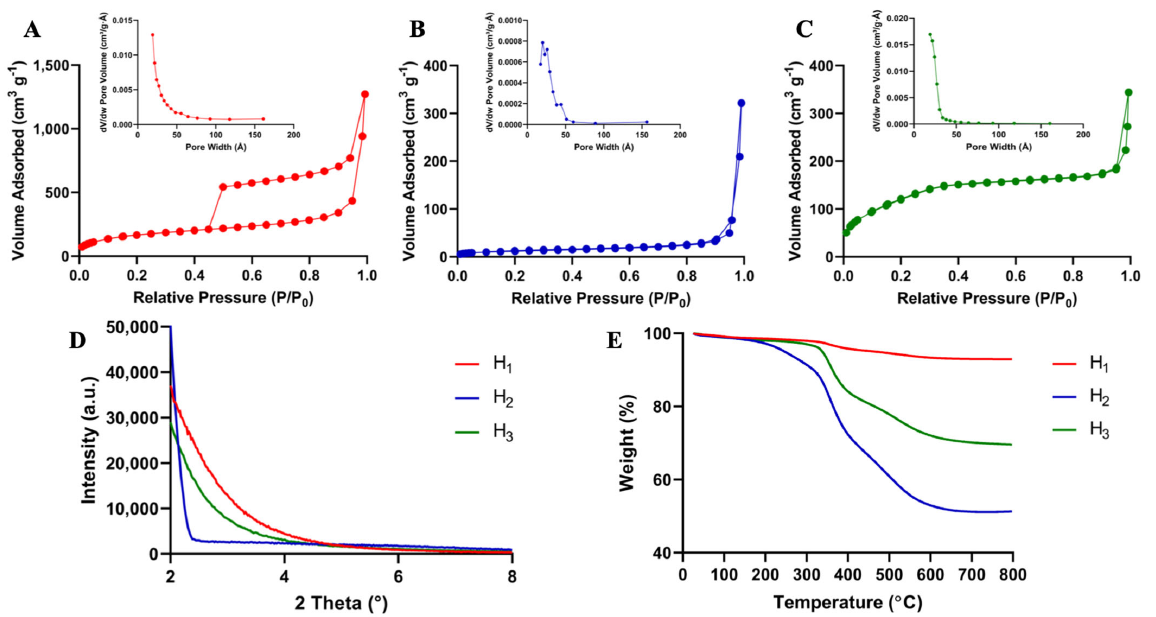
Figure 3. Characterization of layer-by-layer HMSNPs: ( A – C ) Nitrogen sorption graphs for H 1 , H 2 , and H 3 nanoparticles, respectively. All three particles display isotherms characteristic of mesoporous material according to IUPAC classification. Inserts show pore size distribution for nanoparticles in angstrom. H 1 and H 3 display a single peak while several peaks are observed in H 2 due to the decreased formation of uniformed pore structures of the bulky BTEPDS precursor; ( D ) XRD plots for H 1 , H 2 , and H 3 nanoparticles. The lack of typical Bragg peaks in all three particles is indicative of a disordered pore structure. This is commonly observed in organosilica nanoparticles; ( E ) TGA graphs for all the fabricated nanoparticles which exhibit weight loss percentages consistent with layer composition.